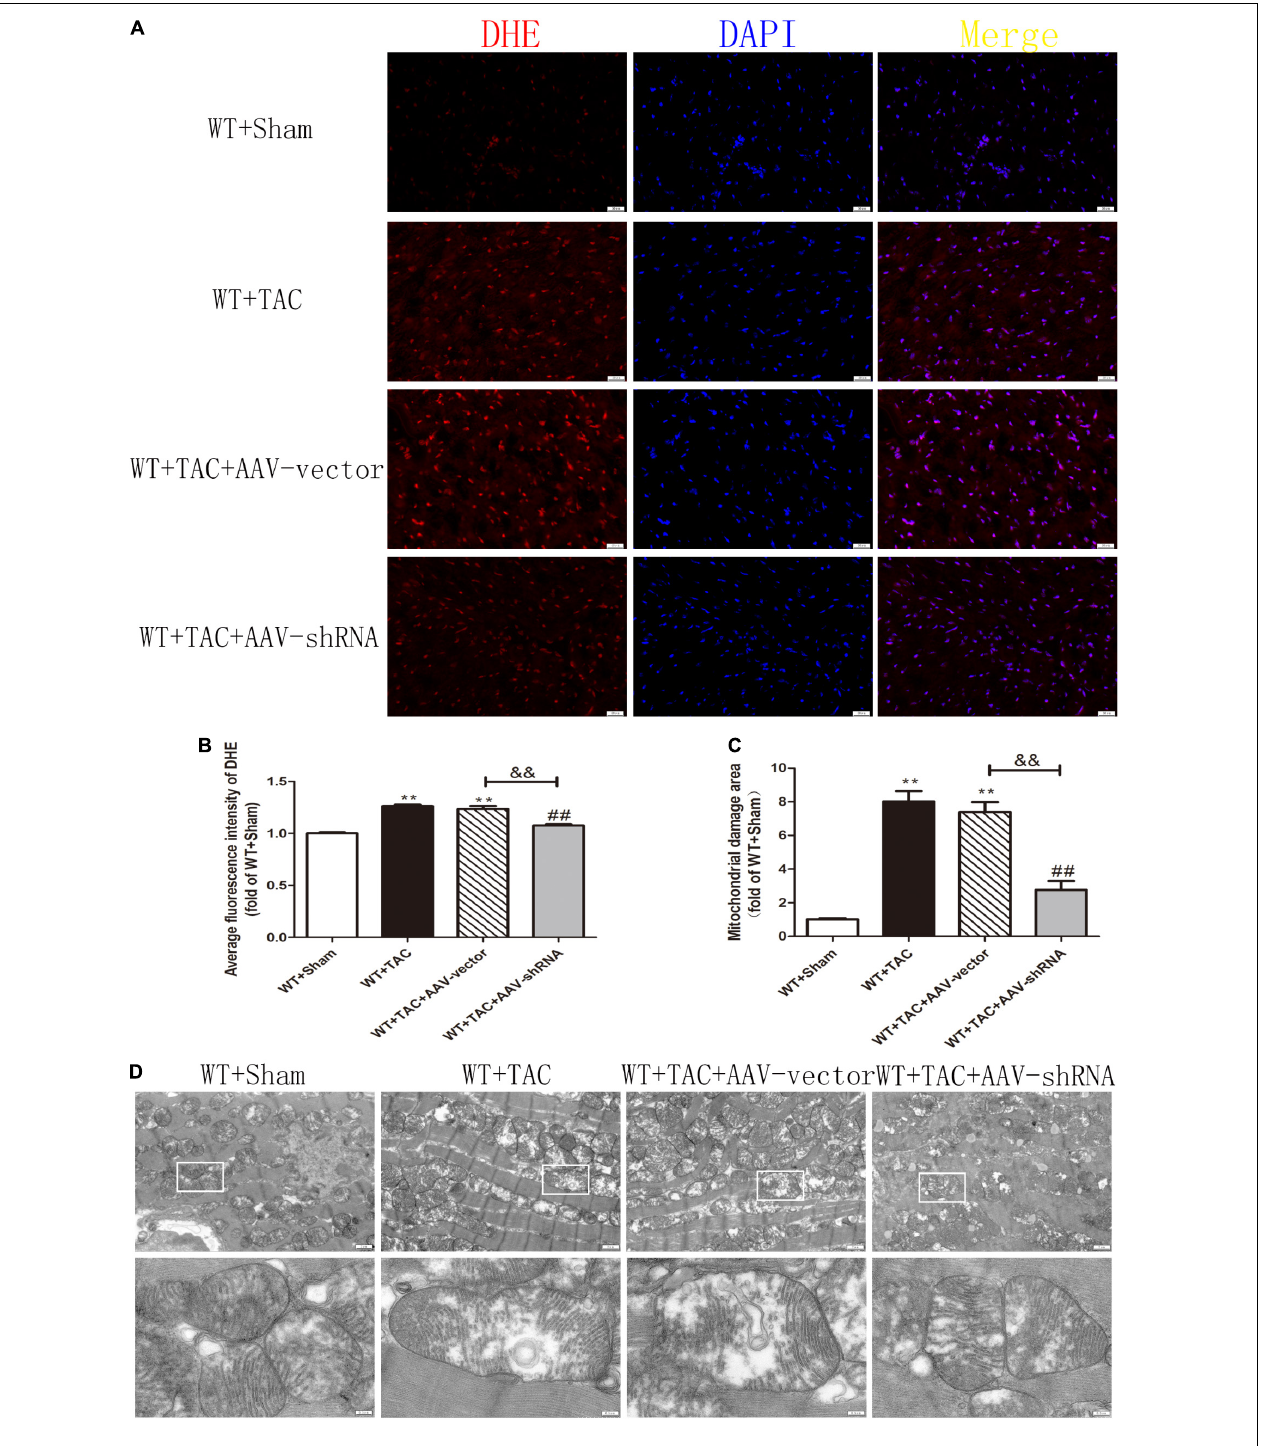
FIGURE 14 | Interference with RIPK3 can reduce ROS accumulation in myocardial tissue of HF mice and improve antioxidant capacity and mitochondrial structural abnormalities. Male 8-week-old WT mice were pretreated with AAV-vector and AAV-shRNA through the tail vein, and TAC was performed using a 28-g needle. The control group received sham surgery. All groups of mice were given continuous feeding for 6 weeks. Hearts were then obtained for correlative testing. (A) DHE staining, bar = 50 µ m. (B) The average fluorescence intensity measurements of DHE staining. (C) Mitochondrial damage area. (D) The ultrastructure of LV mitochondria was observed by transmission electron microscope, bar = 2 µ m. Lower picture bar = 0.5 µ m. Compared with WT + Sham group, ** P < 0.01; compared with WT + TAC group, ## P < 0.01; compared with WT + AAV-vector group, && P < 0.01. n = 6.